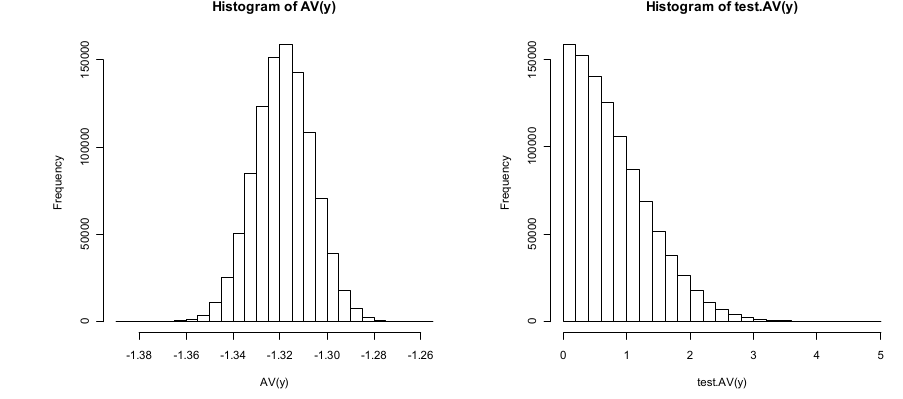
Figure 14 – Distribution of AV ( y ) for n =10 6 . Figure 15 – Distribution of test.AV ( y